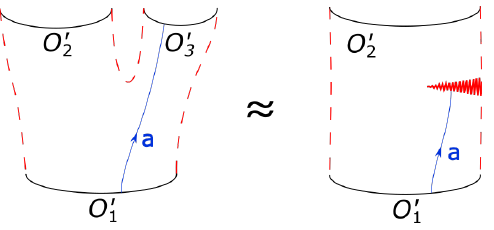
Figure 2 . We can represent each hexagonal worldsheet patch as an ordinary two-dimensional theory with the insertion of a non-local “hexagon operator” which creates an excess angle (the red zig-zag line). This operators may absorb excitations (like particle a in the figure) yielding a non-zero result — its form factor. This form factor is what we are interested in determining starting from the symmetries preserved by the configuration of three operators O